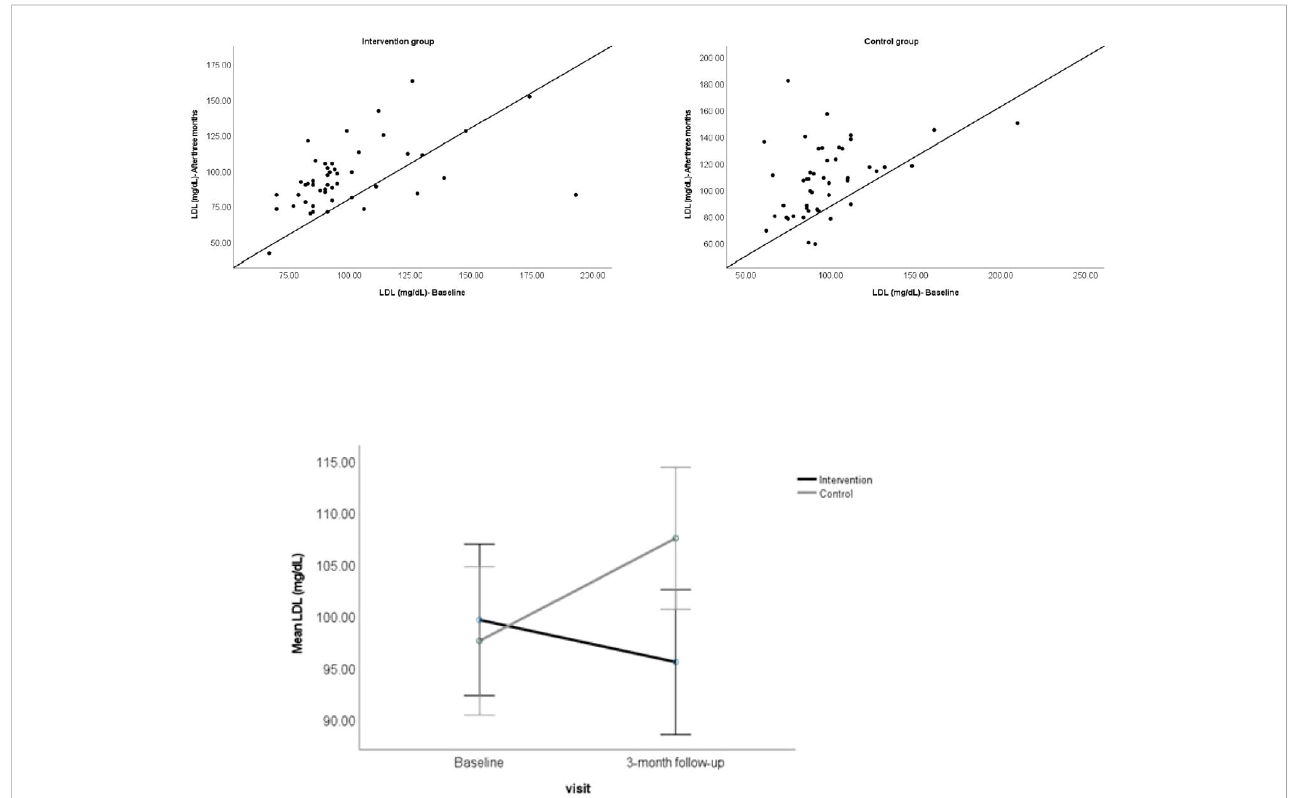
FIGURE 3 Above. Scatterplot showing the LDL for individual participants at baseline and 3-month follow-up visit. Below. Showing the mean LDL for the participant groups at baseline and 3-month follow-up visit. Error bars represent 95%